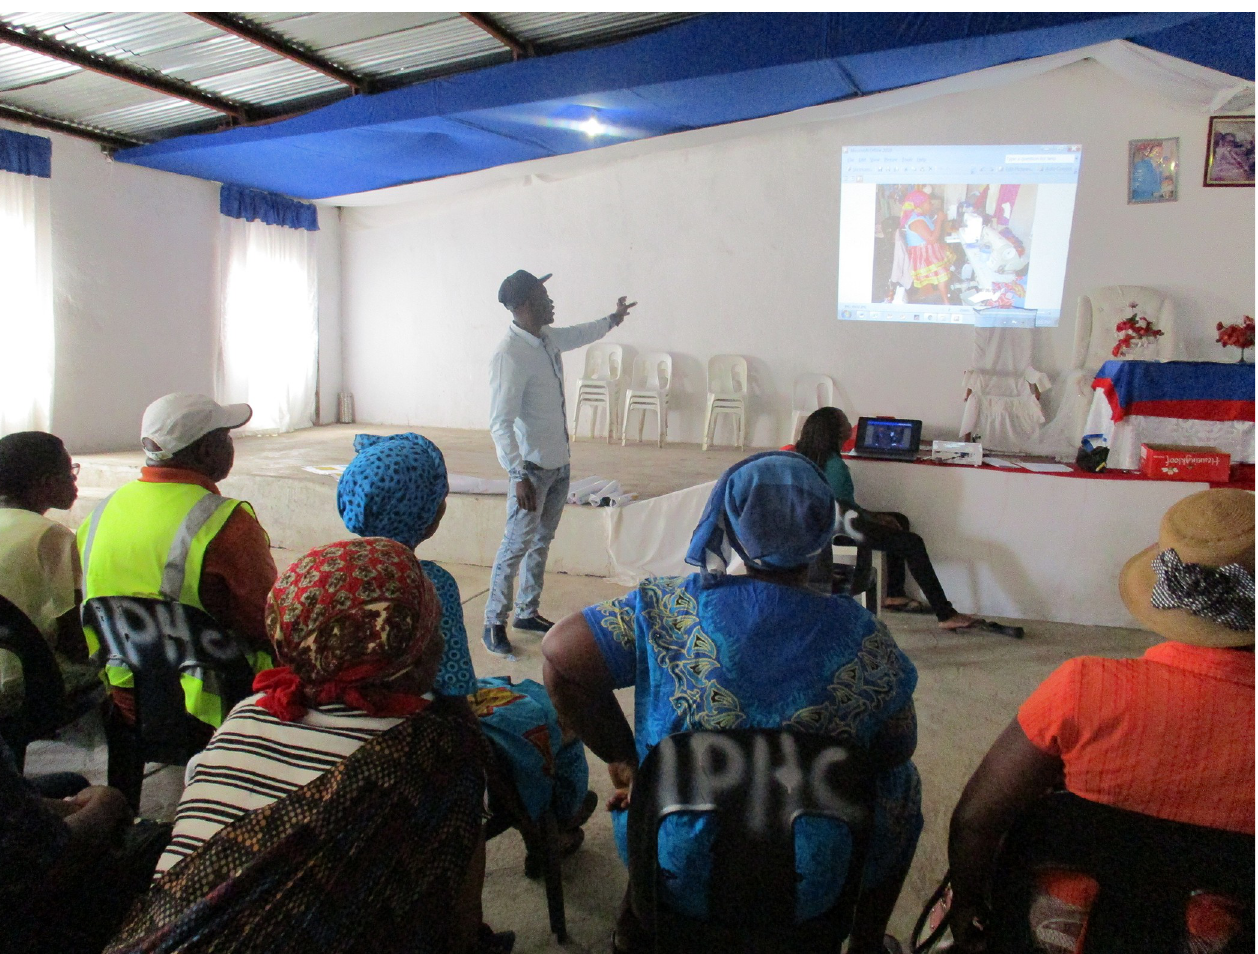
Fig 2. Community stakeholder presenting and appraising visual evidence. Image owned by the VAPAR programme and reproduced with permission in this paper under a creative commons license. Permissions have been secured from participants for the reproduction of all images taken during the course of the